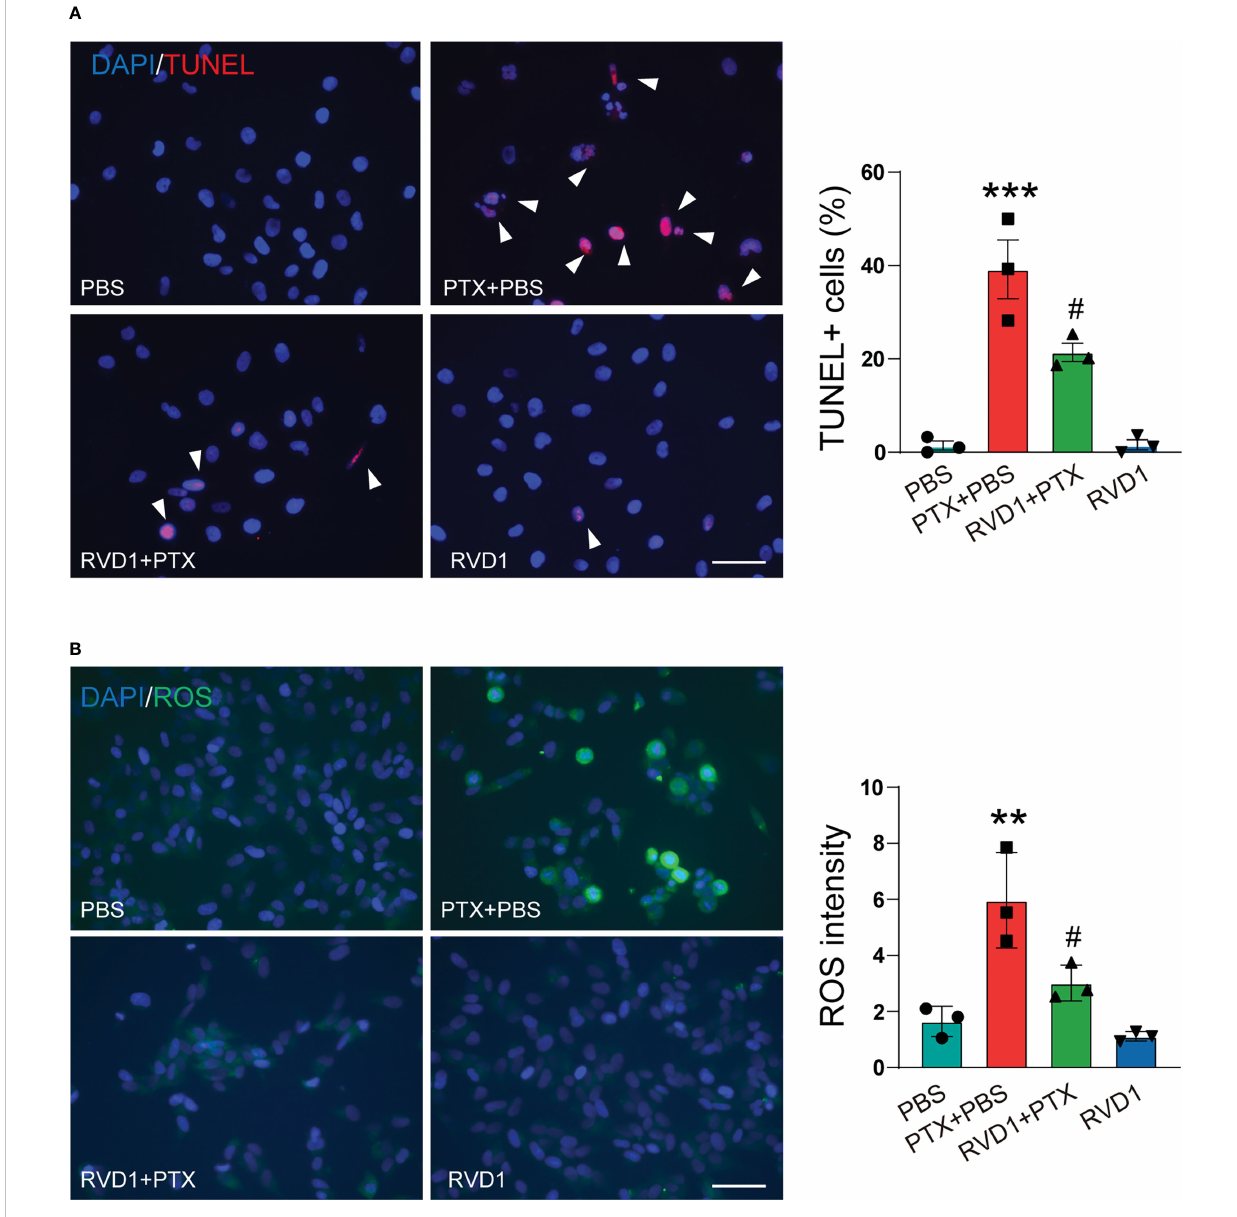
FIGURE 8 RvD1 attenuates the apoptosis of DRG neurons induced by BMDM conditioned medium. BMDMs were treated with RvD1 (250 nm) for 3 h, and then treated with PTX (1 m M) for 24 h, the culture medium was collected and centrifuged, and the supernatant was taken as the condition medium. The primary DRG neurons were stimulated with the above condition medium for 24 h. The apoptosis of neurons was detected by TUNEL staining (A) . The level of ROS was detected by DCFH-DA probe (B) . Blue represents nuclei (DAPI staining), red represents apoptotic cells (TUNEL staining), green represents ROS (DCFH-DA staining). **p < 0.01, ***p < 0.001 vs PBS group; ; #p<0.05 vs PTX+PBS group. Scale bar: 100 m m. RvD1, resolvin D1; PTX,